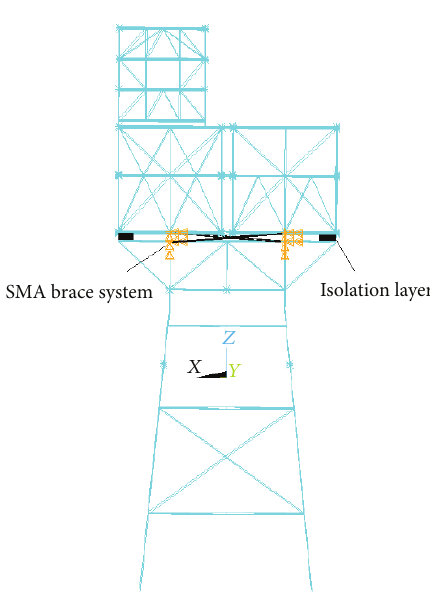
Figure 10: FEM of structure with ISO-SMA.